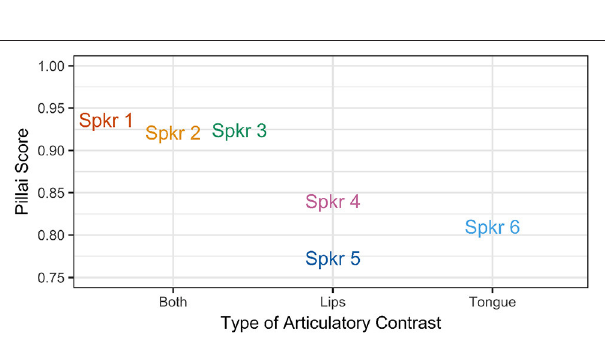
FIGURE 10 | Pillai score for each speaker, by articulatory